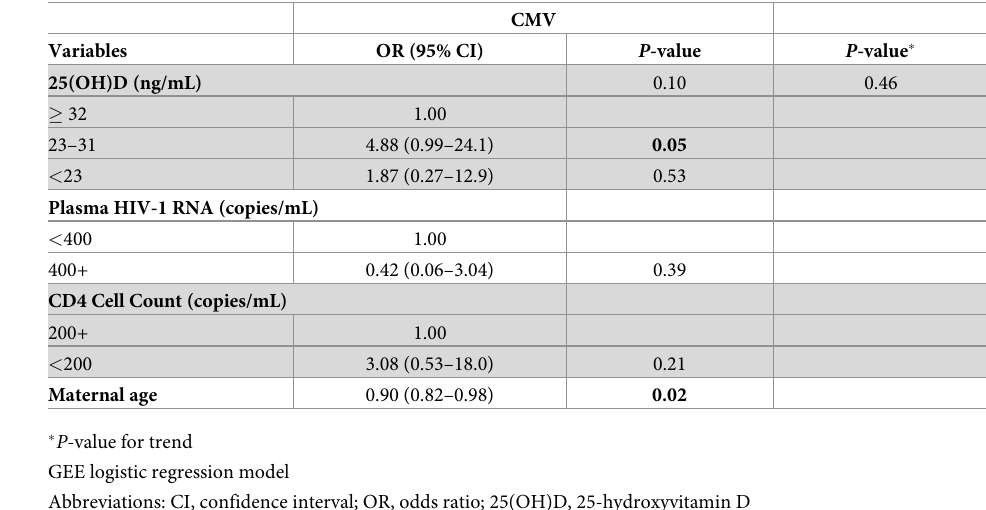
Table 5. Factors associated with congenital CMV in multivariate model